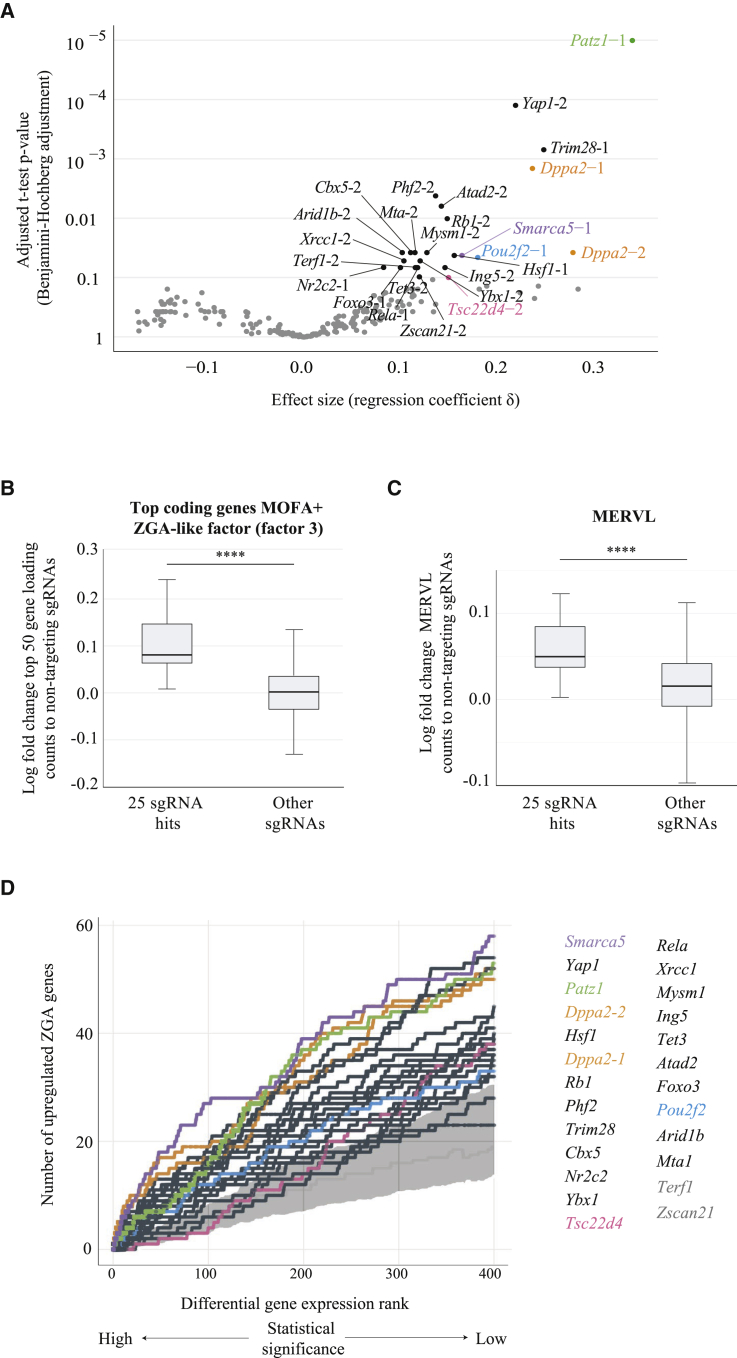
Identification of Activators of a ZGA-like Transcriptional Signature(A) Screen hit rank shown as the effect size (regression coefficient value δ) and the adjusted t test p value (Benjamini-Hochberg adjustment). Target genes with sgRNA(s) at FDR <10% (25 sgRNAs) were considered hits, and their names are displayed (see Table S1 for the full ranking), with Patz1 (green), Dppa2 (orange), Smarca5 (purple), Pou2f2 (blue), and Tsc22d4 (pink) sgRNA hits highlighted.(B) Box-whisker plots showing log fold change expression for the top 50 genes associated with MOFA+ factor 3 (ZGA-like factor, ranked absolute loadings) in cells expressing the 25 sgRNA hits and cells expressing other targeting sgRNAs, compared to cells expressing non-targeting sgRNA controls. Expression is quantified in normalized counts (∗∗∗∗p value = 3.7 × 10−10, Mann-Whitney two-tailed test).(C) Box-whisker plots showing log fold change of MERVL normalized counts in cells expressing the 25 sgRNA hits and cells expressing other targeting sgRNAs, compared to cells expressing non-targeting sgRNA controls (∗∗∗∗p value = 8.2 × 10−7, Mann-Whitney two-tailed test).(D) Cumulative rank of the number of ZGA signature genes (as described in Table S2) upregulated by each sgRNA hit compared to non-targeting sgRNA controls, considering the top 400 genes ranked by statistical significance of differential gene expression test (generalized linear model likelihood ratio test as implemented in EdgeR). In gray is shown an empirical background distribution estimated based on differential gene expression between cells with non-targeting sgRNA controls, displaying plus and minus one standard deviation around the mean of ZGA signature genes recovered by non-targeting sgRNAs. The names of the target genes for sgRNAs identified as hits in A) are depicted, with those for which the differential gene expression rank overlaps with the non-targeting control background shown in gray. Patz1 (green), Dppa2 (orange), Smarca5 (purple), Pou2f2 (blue), and Tsc22d4 (pink) sgRNA hits are highlighted.